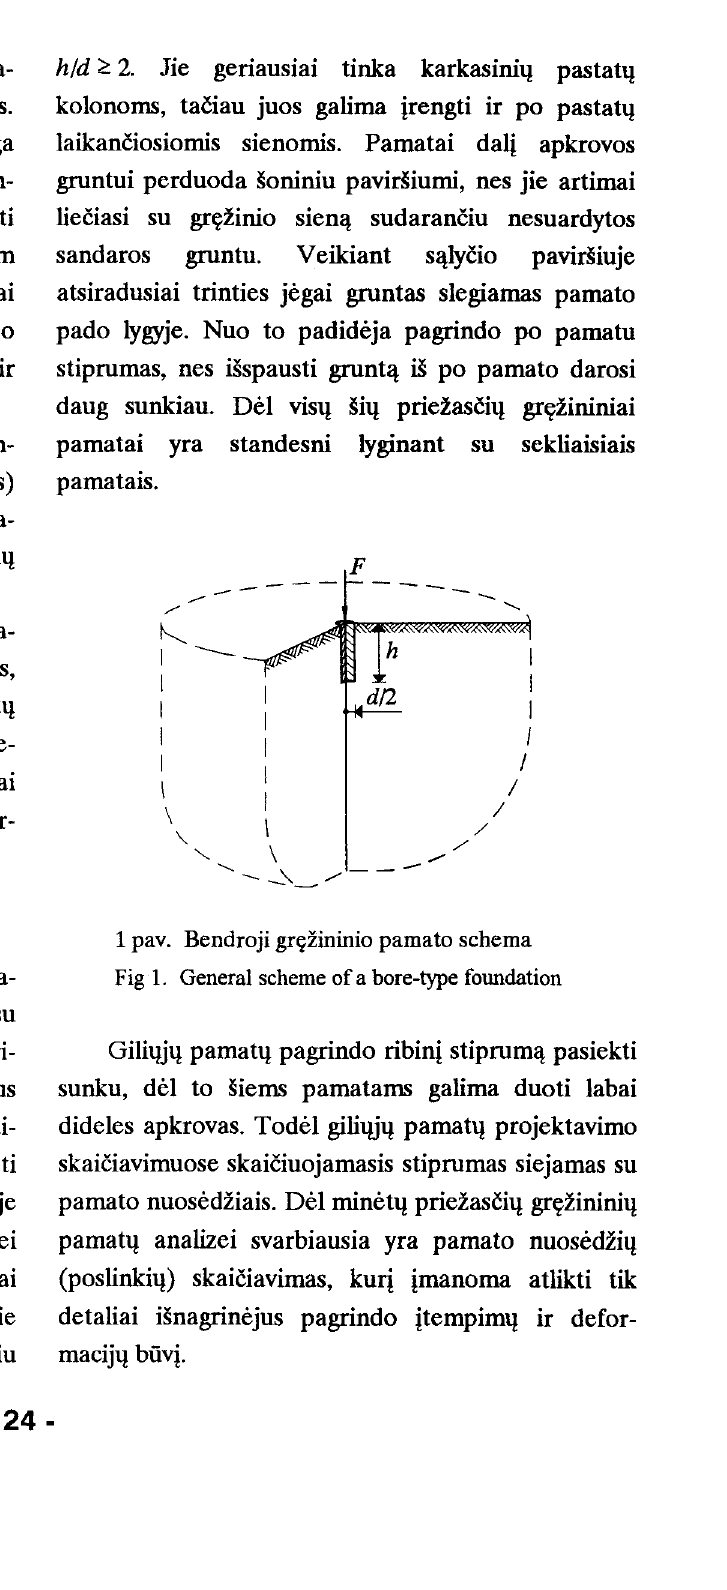
detaliai isnagrinejus pagrindo itempimq ir defor macijq